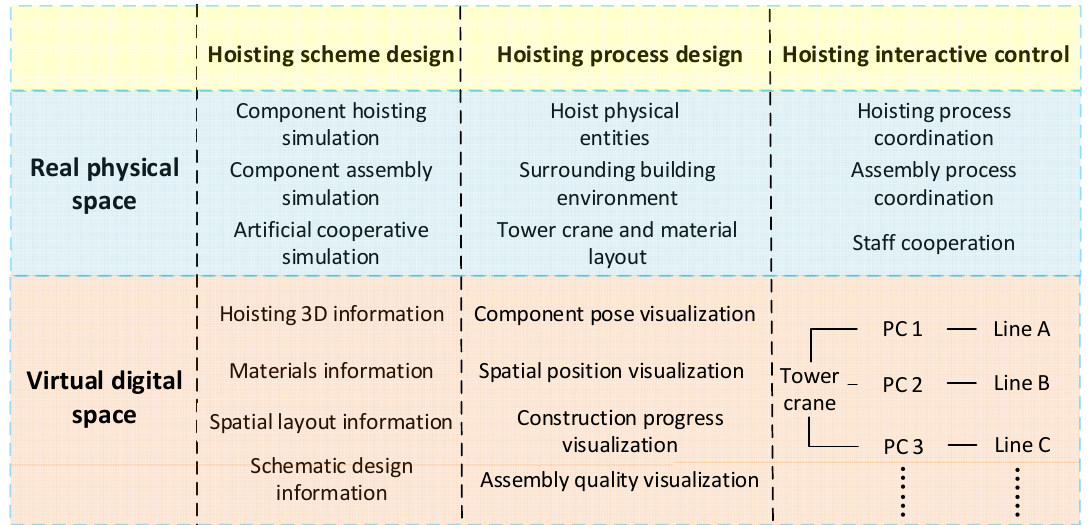
Figure 7. Mapping elements of virtual-real twin for hoisting of PCs.